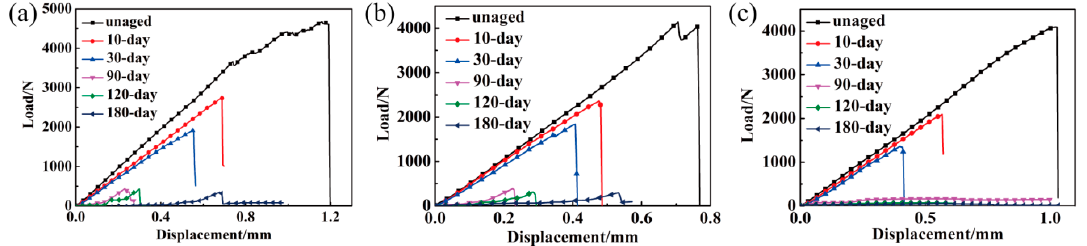
Figure 6. The load-displacement curves for ( a ) the Com 1#, ( b ) the Com 2#, and ( c ) Com 3# at 250 °C aged for different periods.